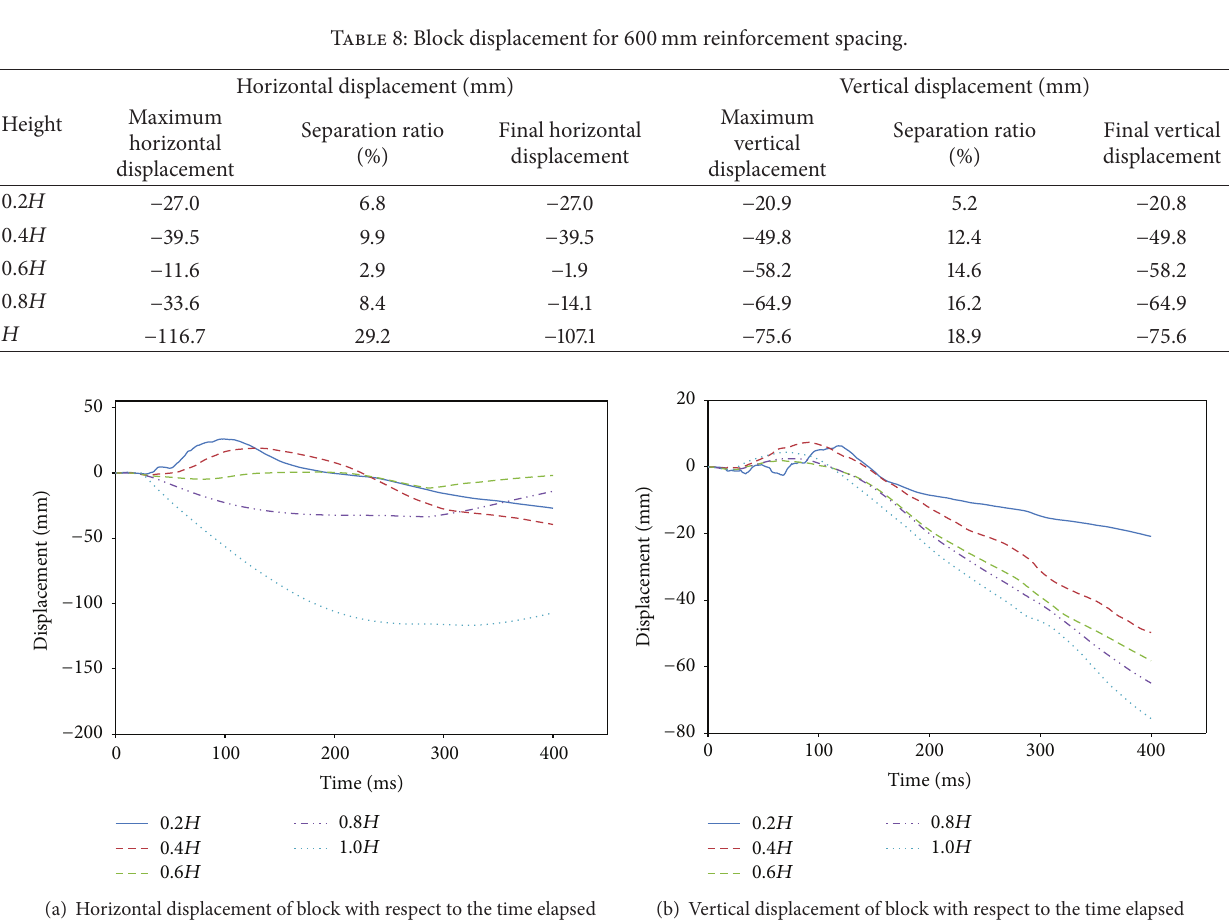
Figure 8: Block displacement for 600 mm reinforcement